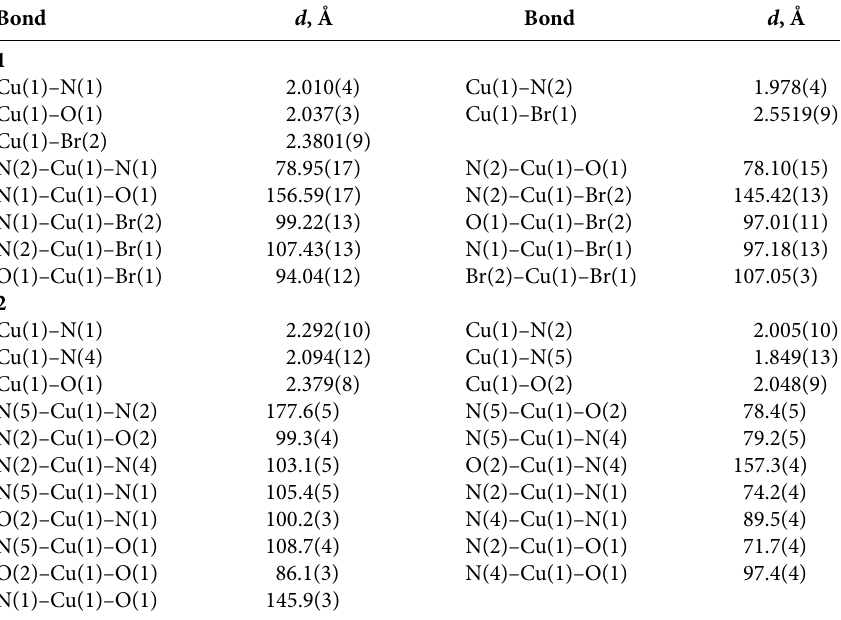
Table 2. Selected bond distances (Å) and bond angles (º) for the complexes Bond d , Å Bond d ,